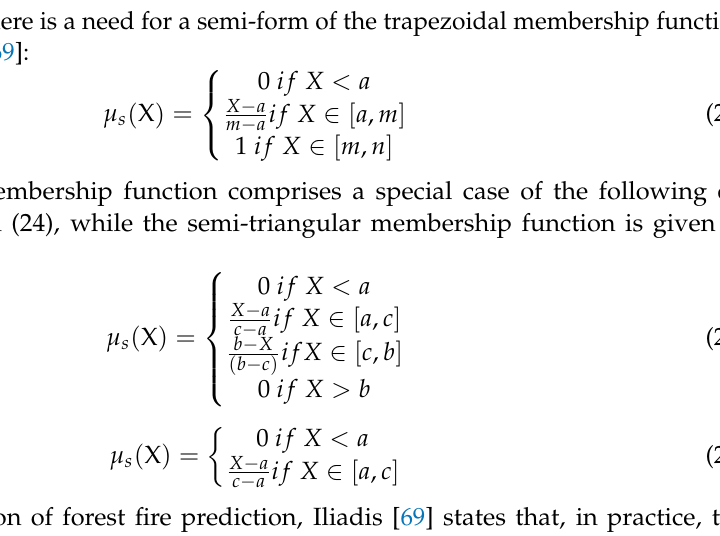
Figure 12. An example of the trapezoidal membership function.